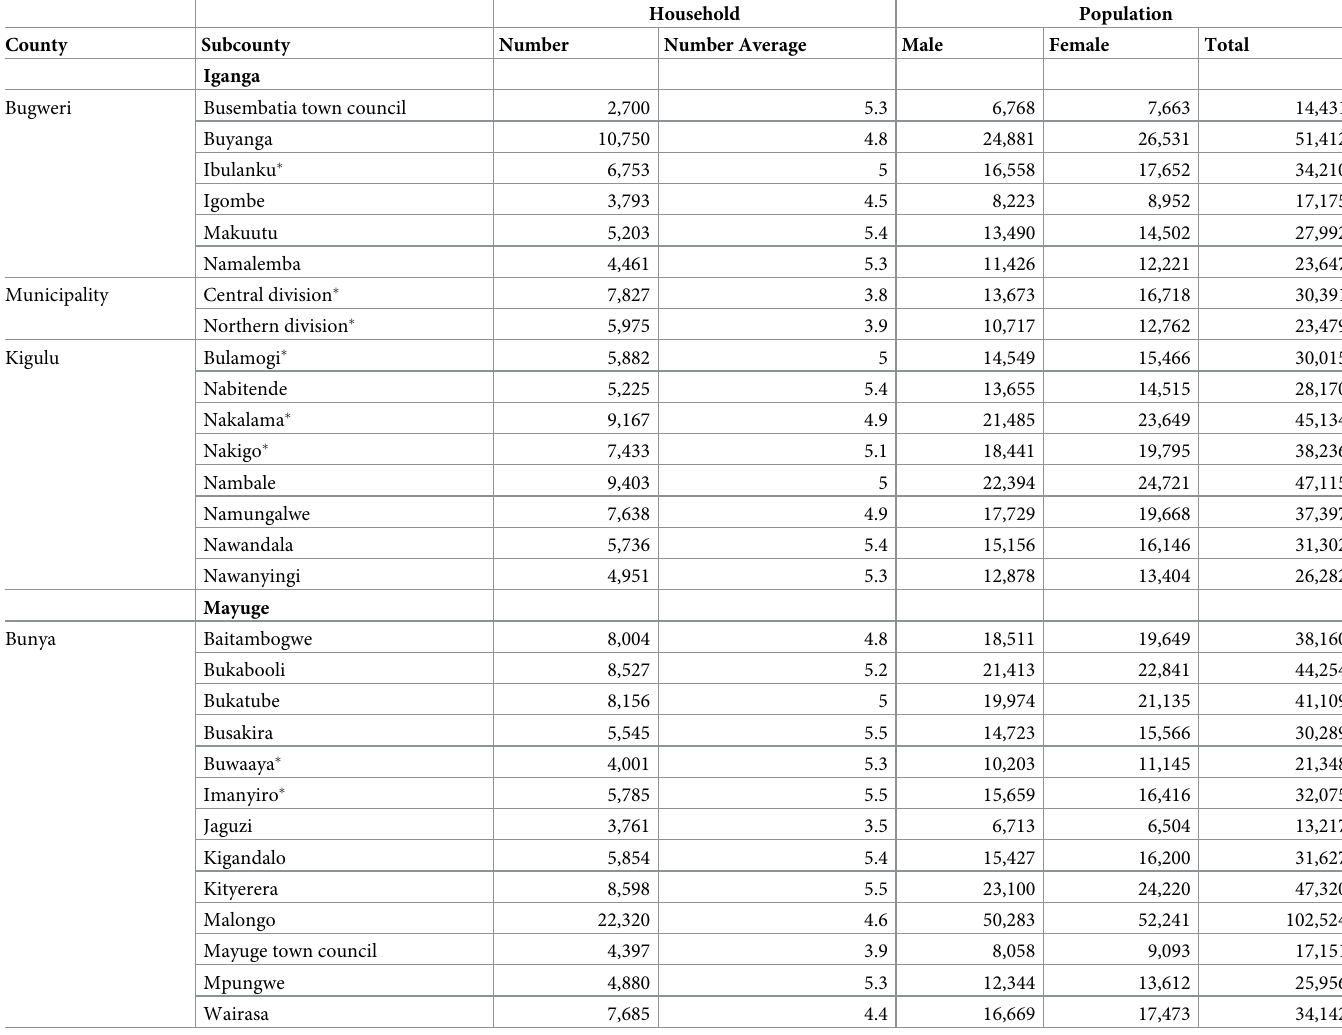
Table 1. Estimated number of household and population in Iganga-Mayuge